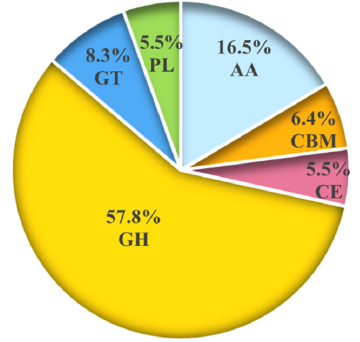
Figure 2. Analysis of six types of carbohydrate-active enzymes (CAZymes) in the secreted proteins of P. italicum. GHs: glycoside hydrolases, CEs: carbohydrate esterases, PLs: polysaccharide lyases, GTs: glycosyltransferases, AAs: auxiliary module enzymes, CBMs: carbohydrate-binding